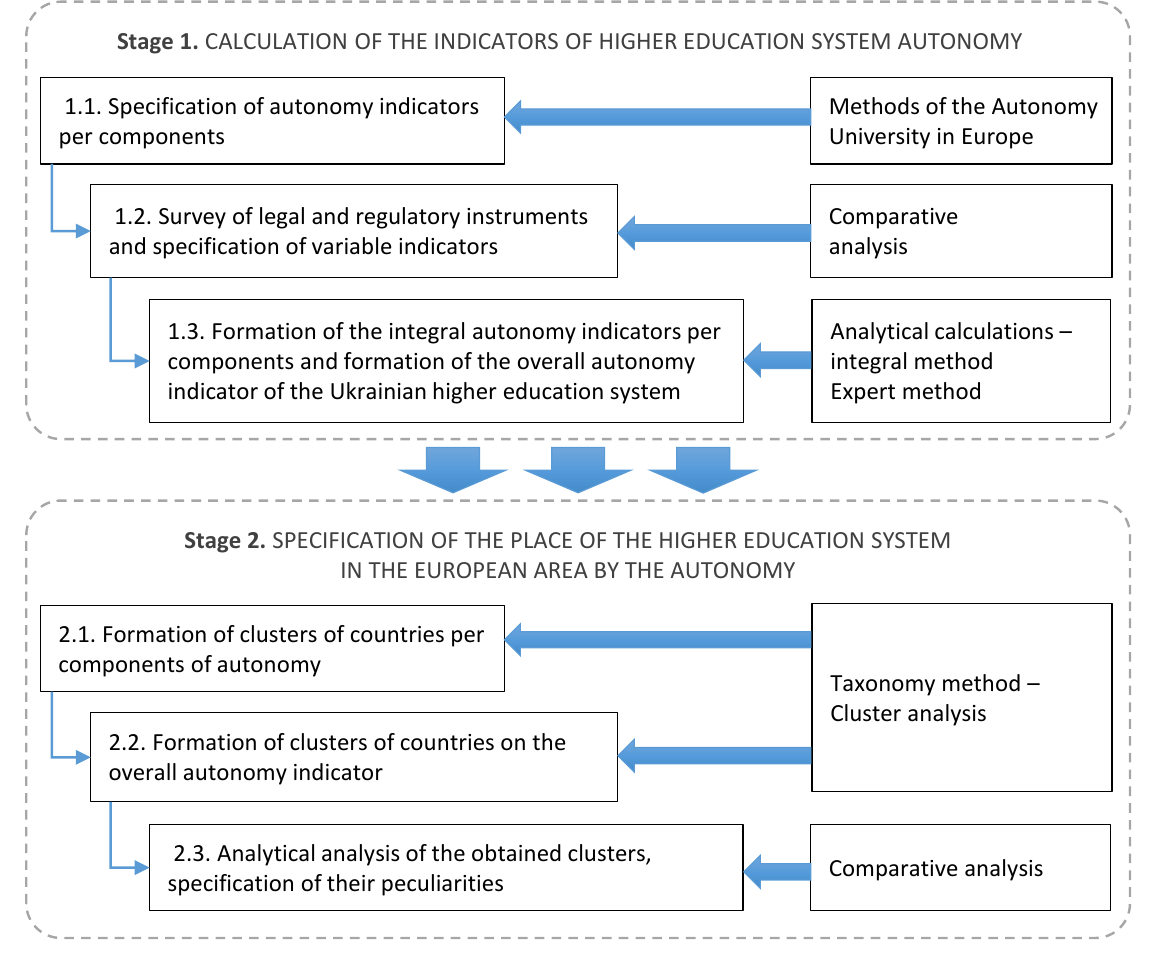
Figure 1. Algorithm of examining the autonomy of the higher education system in